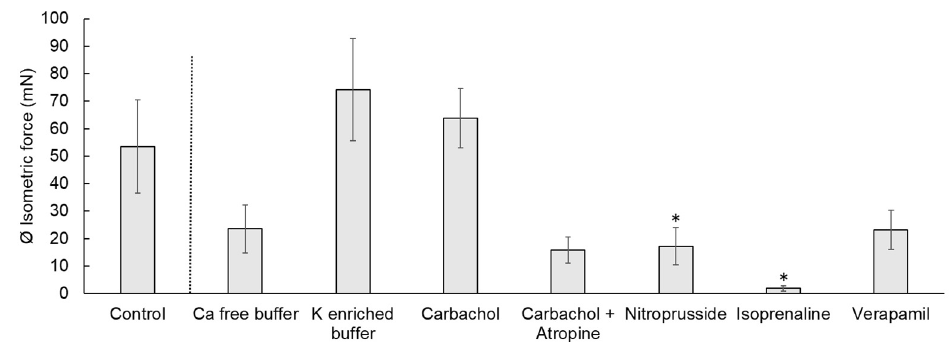
Figure 3. Isometric force of the contraction of chicken circular cecal smooth muscle. The control condition and the reactions to different electrolytes or drugs are shown. Values are given as mean ± standard error of the mean (SEM). The treatments were compared to the control condition and significant differences are indicated by * at p < 0.05. Table 1. Frequency (contractions/2 min) of the physiological smooth muscle contraction of the cecum and changes in the frequency as affected by electrolytes and drugs. The results show frequencies for the control conditions (physiological contraction) and treatments. The values are given as mean and standard error of the mean (SEM). Significant differences were defined as p < 0.05 between the treatments and the physiological contractions. n.s. = not significant. -= not defined. N = number of